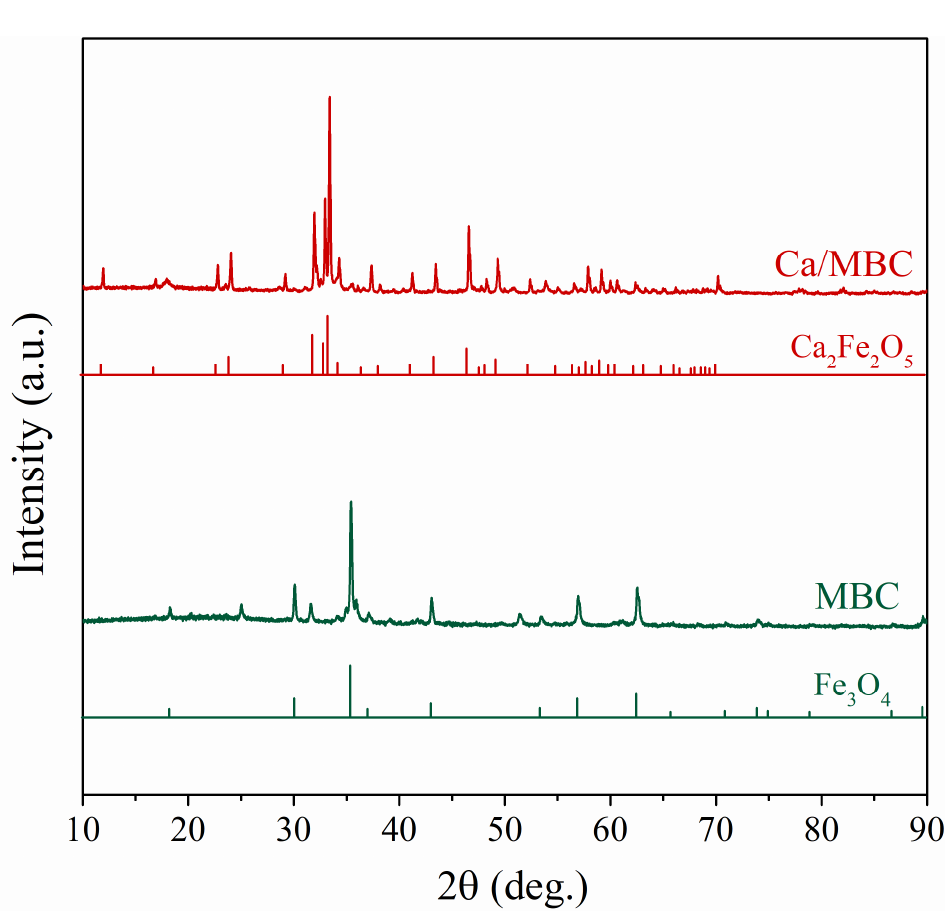
Figure 3. XRD spectra of BC, MBC, and Ca/MBC.